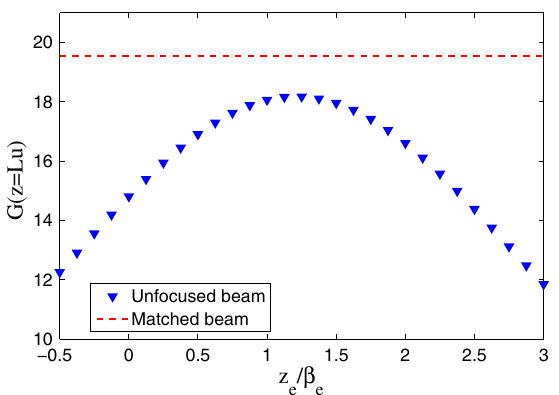
¼ 34 : 45 m ) vs scaled FIG. 14. Total gain (i.e., gain at z ¼ L u waist position (blue markers) for an FEL driven by an unfocused ¼ 13 : 78 m (Set 2 parameters). Also shown is the beam with (cid:7) e gain for a matched beam (red dashed